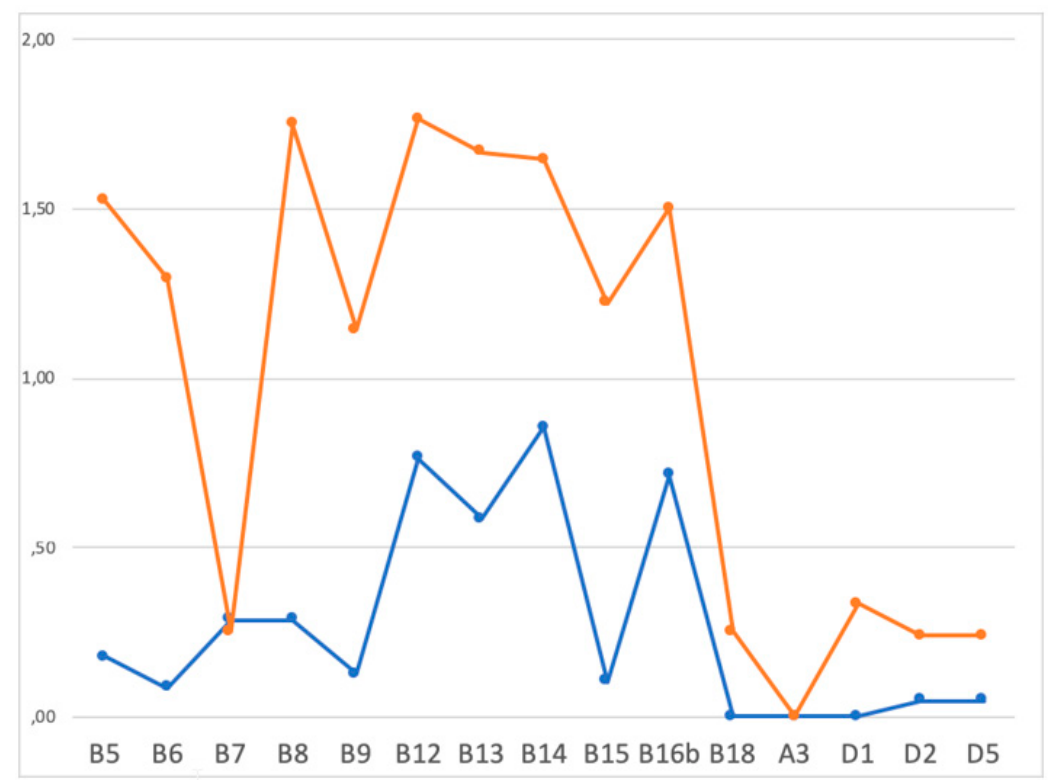
Figure 5. Different scores in the various ADOS sub-items in infants receiving a diagnosis of ASD (orange curve) and in those without (blue curve) at 24 months of age. ADOS sub-items: B5: integration of eye contact; B6: shared enjoyment; B7: response to name; B8: ignoring; B9: asking; B12: showing; B13: begin to joint attention; B14: response to joint attention; B15: quality of social engagement; B16b: frequency of social engagement to parents; B18: quality of general interaction; A3: verbalizations’ tone; DI: abnormal sensorial interests; D2: stereotyped movements; D5: stereotyped behaviors.